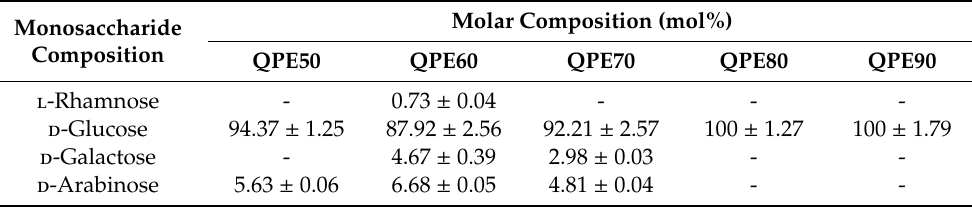
Table 2. Monosaccharide composition of di ff erent QPs